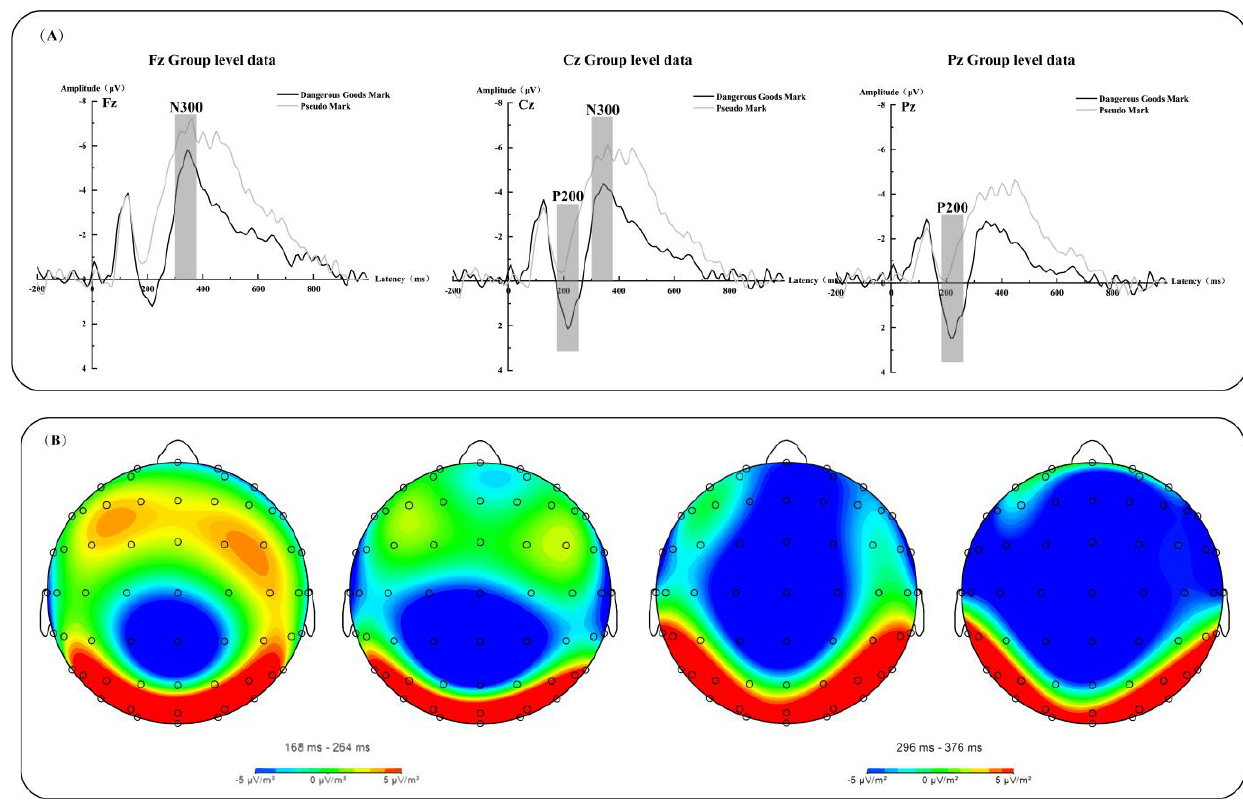
Figure 4. ERP results. Grand average event-related potentials of the P200 and N300 evoked by the standard stimulus at three electrodes in the frontal, central parietal, and parietal regions (FZ, Cz, and Pz): ( A ) grand average event-related potentials evoked by dangerous goods marks and pseudo-marks at three electrodes in the frontal, central parietal, and parietal regions and ( B ) topographic maps of the P200 (170–260 ms) and N300 (300–380 ms) in the dangerous goods mark and pseudo-mark conditions.